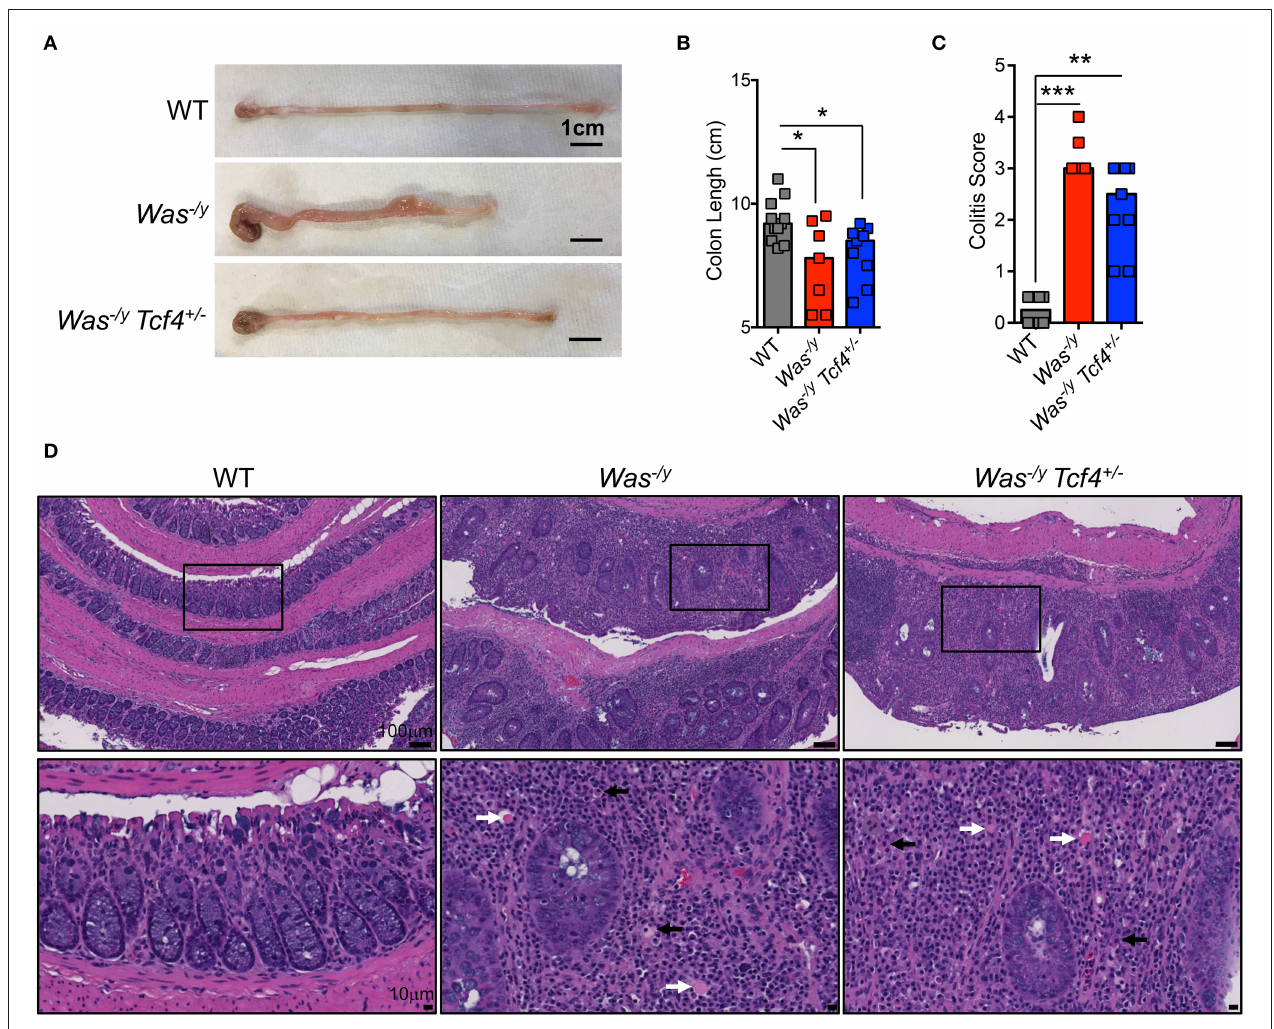
FIGURE 4 | No significant impact of Tcf4 haplodeficiency on colitis development in Was -deficient mice. WT, Was − / y or Was − / y Tcf4 + / − mice were analyzed at 30 weeks of age. (A) Representative pictures of colon (scale bars, 1cm) and (B) colon lengths from individual mice of the indicated genotype are shown. Bars represent median value. Data were pooled from 4 independent experiments. (C) Histopathological scores of the colon pathology were determined from individual indicated animals. Bars represent the median, and data were pooled from 3 independent experiments. (D) Colon paraffin sections of the indicated mice were stained by hematoxylin and eosin (H&E) and analyzed by microscopy. Upper panels taken at 10X magnification (scale bar, 100 µ m) and lower panels show a 40X magnification (scale bar, 10 µ m) of the indicated area (square). In the magnified panels, black arrows indicate plasma cells and white arrows Russell bodies. Images are representative of at least 5 animals in each group from 3 independent experiments. Statistical significance estimated by Kruskal-Wallis test followed by a post-hoc Dunn’s multiple comparison test is indicated as follows * P ≤ 0.05, ** P ≤ 0.01, *** P ≤